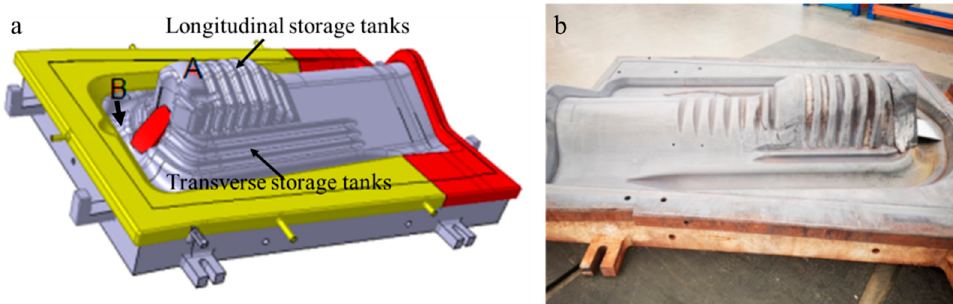
Figure 9. Male die of the preforming process: ( a ) optimized model; ( b ) machined die. (1) Drawing of the preforming